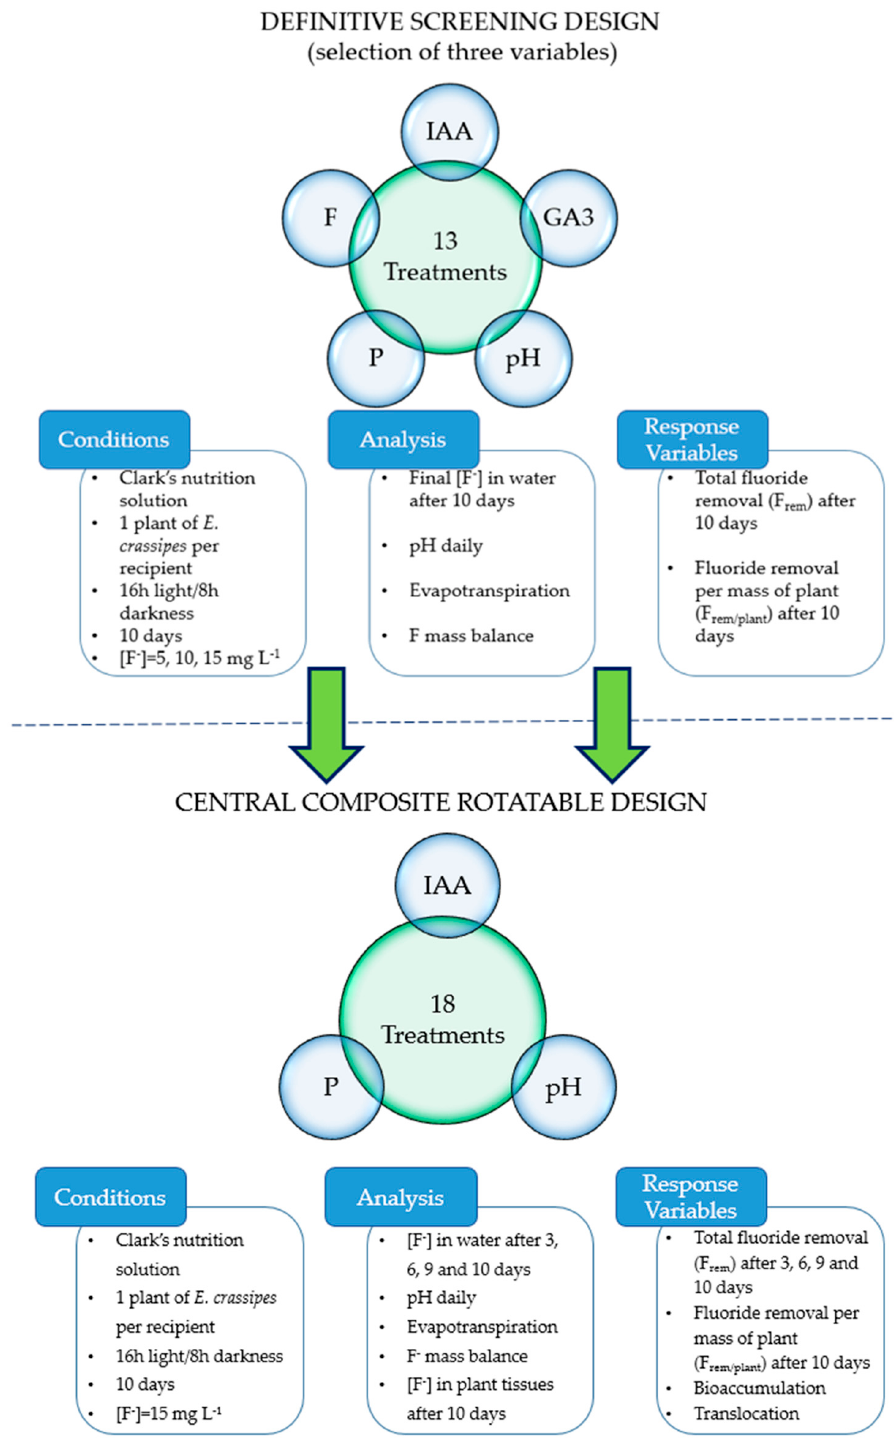
Figure 1. Flowchart of experimental set up presenting two subsequent experiments and their respec- tive conditions, analyses, and response